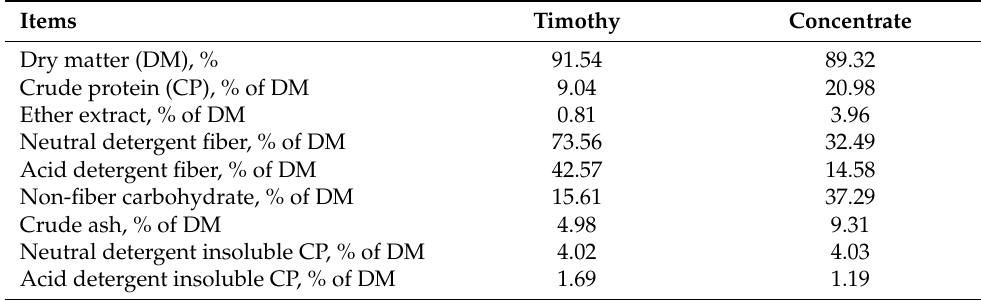
Table 1. Chemical composition of basal